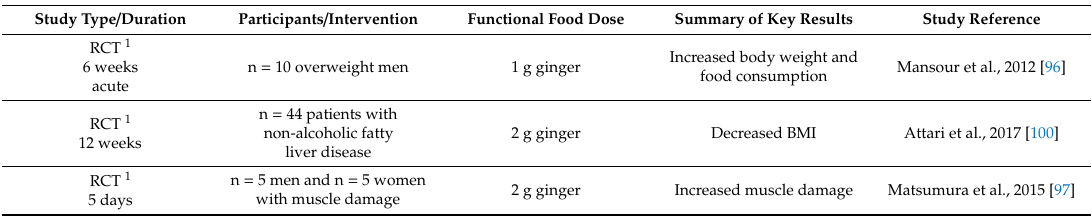
Table 7. Human intervention clinical studies about the possible e ff ects of ginger on body weight control, obesity, and its metabolic